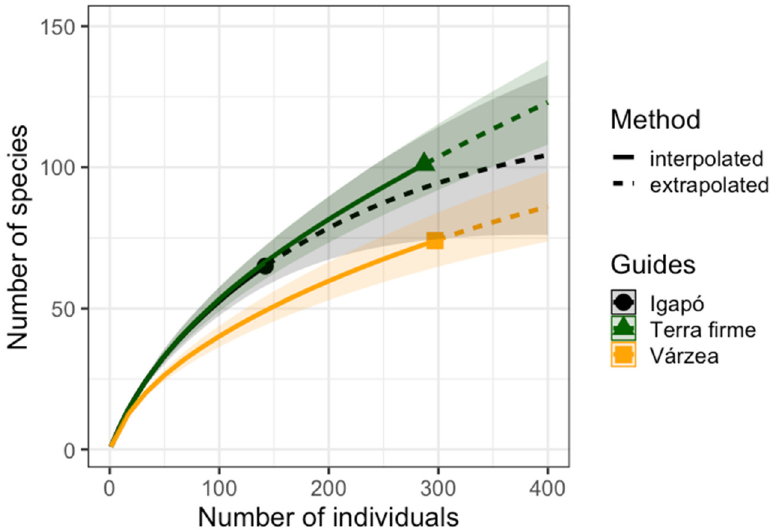
Figure 2. Species accumulation curves (interpolated and extrapolated) for the butterfly assemblages in three forest types in the lower Purus region, central Amazonia, Brazil. The solid lines show the cumulative number of species as a function of the number of individuals sampled in terra firme (green triangle and lines), várzea (yellow square and lines), and igapó (black circle and lines). Dashed lines indicate the extrapolated species number with a standardized number of individuals ( n = 400) in each forest type and the shaded areas represent 95% confidence intervals.